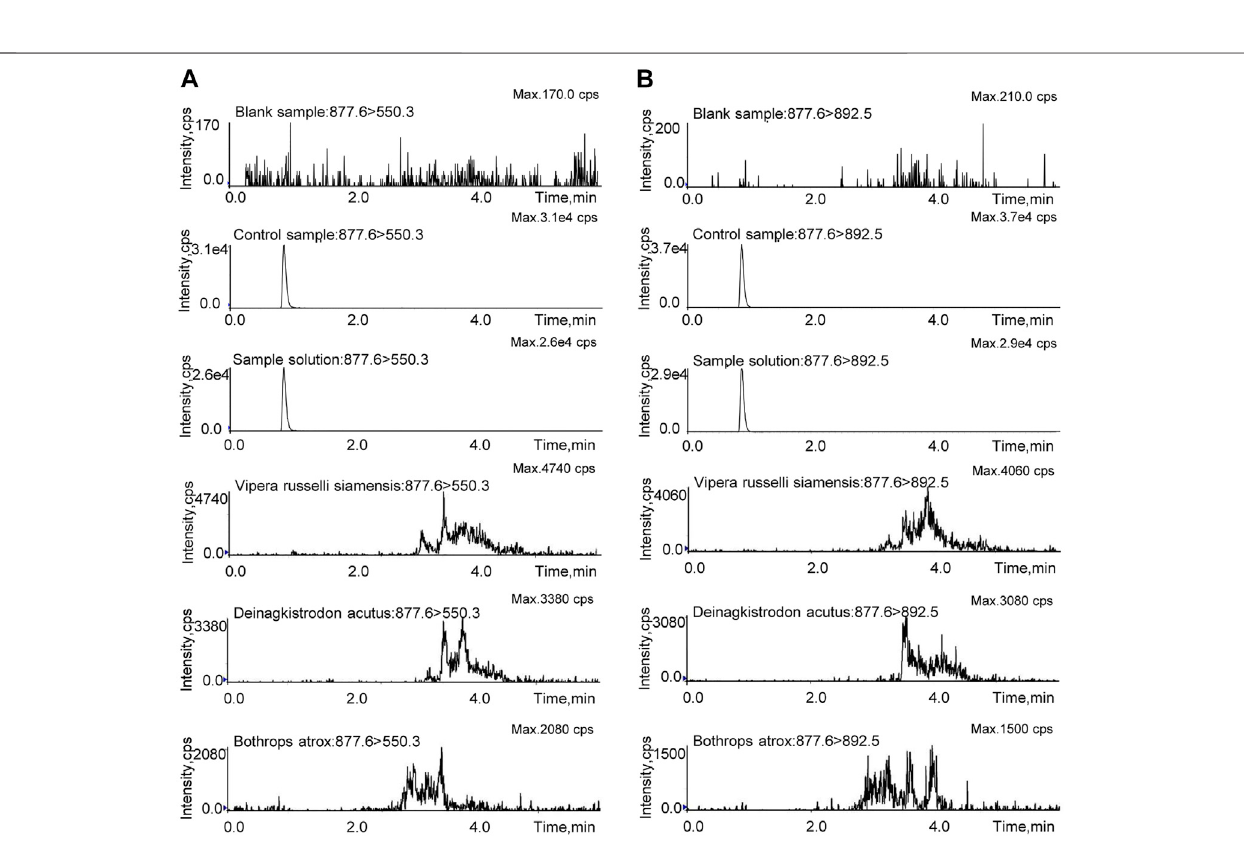
Frontiers in Molecular Biosciences |